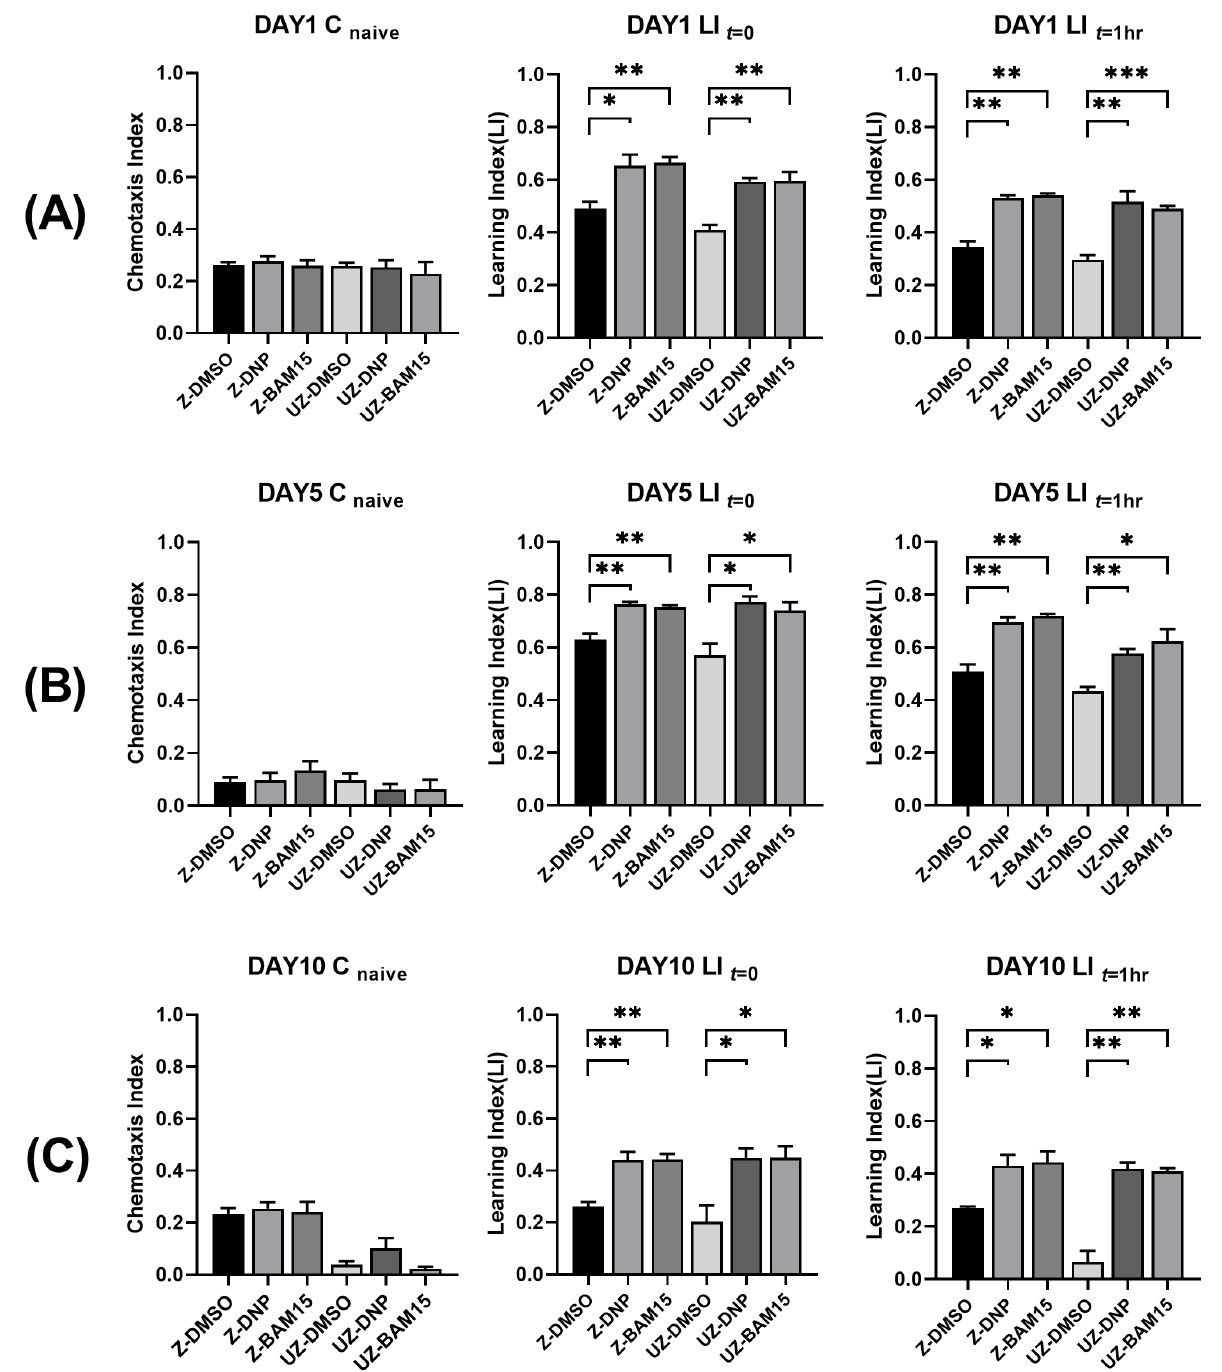
Figure 3. BAM15 retains learning ability and short-term memory in aged C. elegans . ( A – C ) Naive Chemotaxis Index (CI) and Learning Index (LI) in zdIs5 and ucp-4 ; zdIs5 treated with 10 µ M DNP and 50 µ M BAM15 on Day 1 ( A ), Day 5 ( B ), and Day 10 ( C ). t = 0, right after the training; t = 1 h, 1 h after the training. Z-DMSO—DMSO control in zdIs5 ; Z-DNP—10 µ M DNP treatment in zdIs5 ; Z-BAM15—50 µ M BAM15 treatment in zdIs5 ; UZ-DMSO— ucp-4 ; zdIs5 treated with DMSO; UZ-DNP— ucp-4 ; zdIs5 treated with 10 µ M DNP; UZ-BAM15— ucp-4 ; zdIs5 treated with 50 µ M BAM15. Data are represented as means of three independent experiments. Error bars represent the SEM. n = 150~300 worms per treatment in each experiment. * p < 0.05, ** p < 0.01, *** p < 0.001. Unpaired Student’s t -tests were performed to compare the DMSO control and treatments.